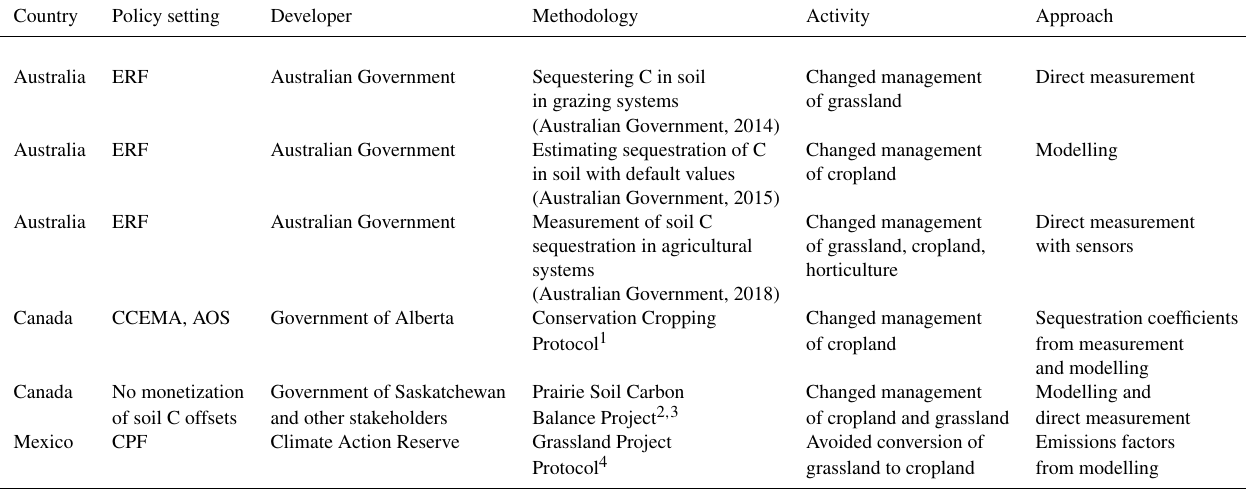
Table 1. Examples of methodologies for estimating change in soil organic C for mitigation actions related to changed management of agri- cultural land. Emissions Reduction Fund (ERF); Climate Change and Emissions Management Act (CCEMA); Alberta Offset System (AOS); Climate Policy Framework